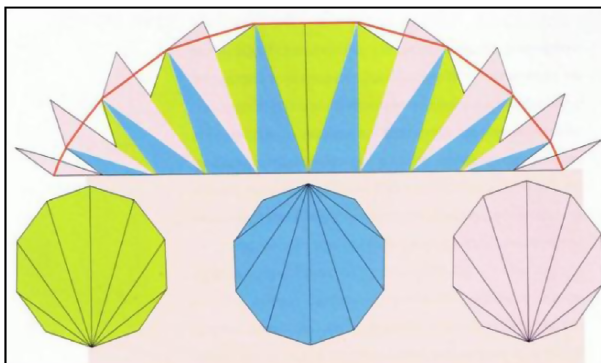
Figure 33. Determining the area under a polygonal arch.